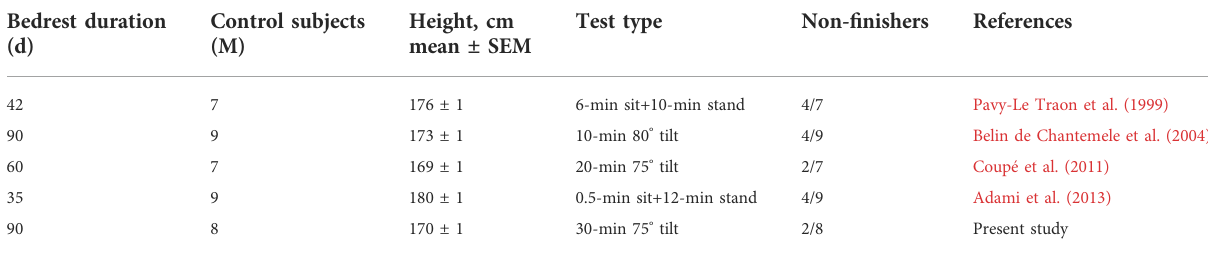
TABLE 4 Height and orthostatic tolerance after long-term bedrest without countermeasures in men. Bedrest duration